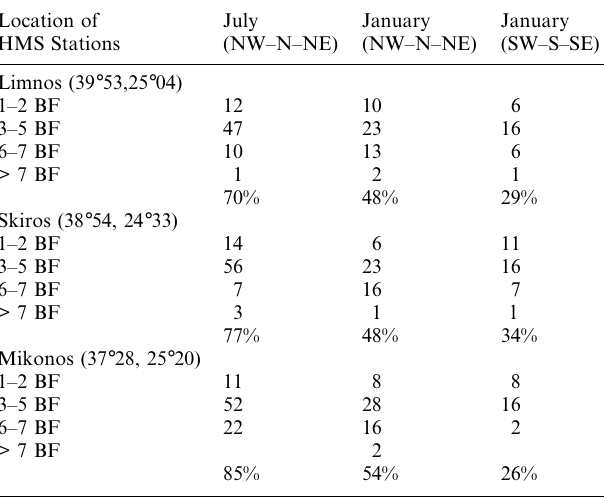
Table 1. North-south wind distribution in July and January in the Aegean Sea Location of HMS